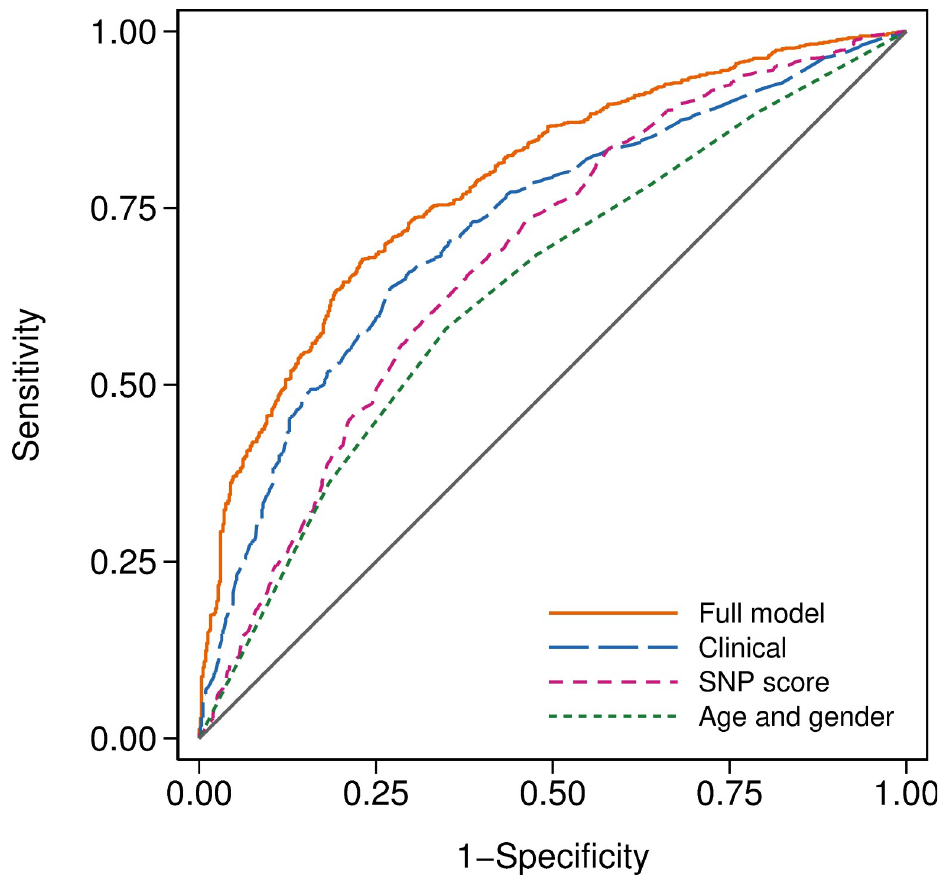
Fig 1. Receiver operating characteristic curves for models with different amounts of information. The area under the receiver operating characteristic curve was 0.786 for the full model, 0.723 for the clinical model, 0.680 for the SNP score, and 0.635 for the age and gender